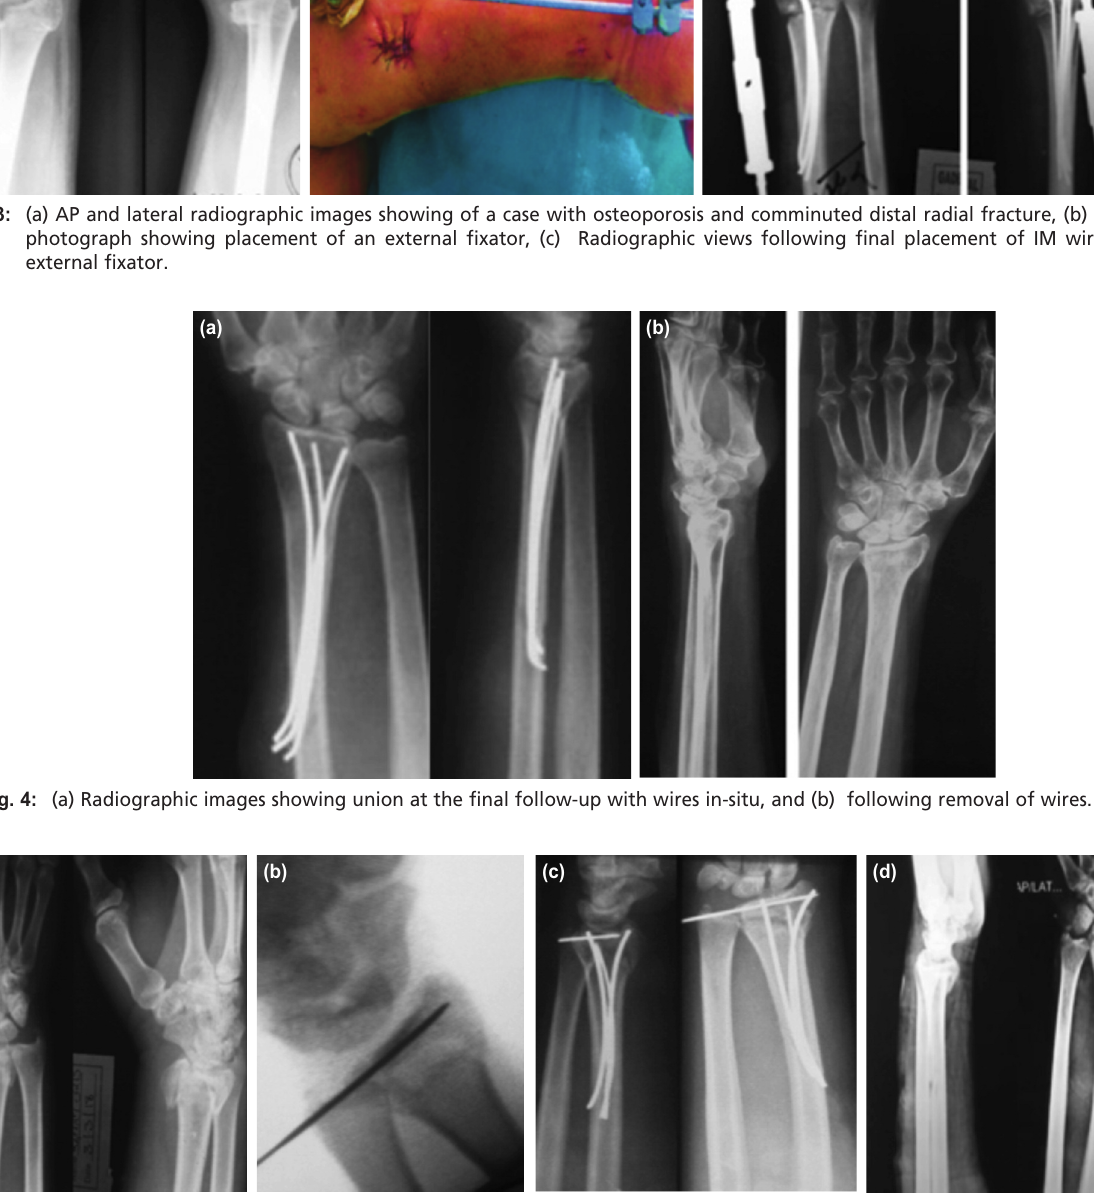
Radiographic images showing series of pre-operative to post-operative progression for one patient without the use of external Fig. 5: fixation; (a) images showing comminuted distal radial fracture with instability of the DRUJ, (b) K-wire pinning across the DRUJ, (c) post-operative images following fixation, (d) and AP and lateral images at final follow-up showing radiographic